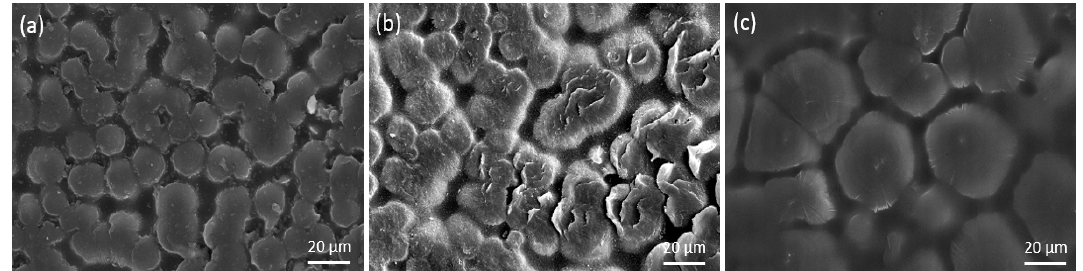
Figure 5. SEM micrographs showing samples of different materials after etching: ( a ) 70 L-30 H, ( b ) LLDPE, and ( c ) XLPE.